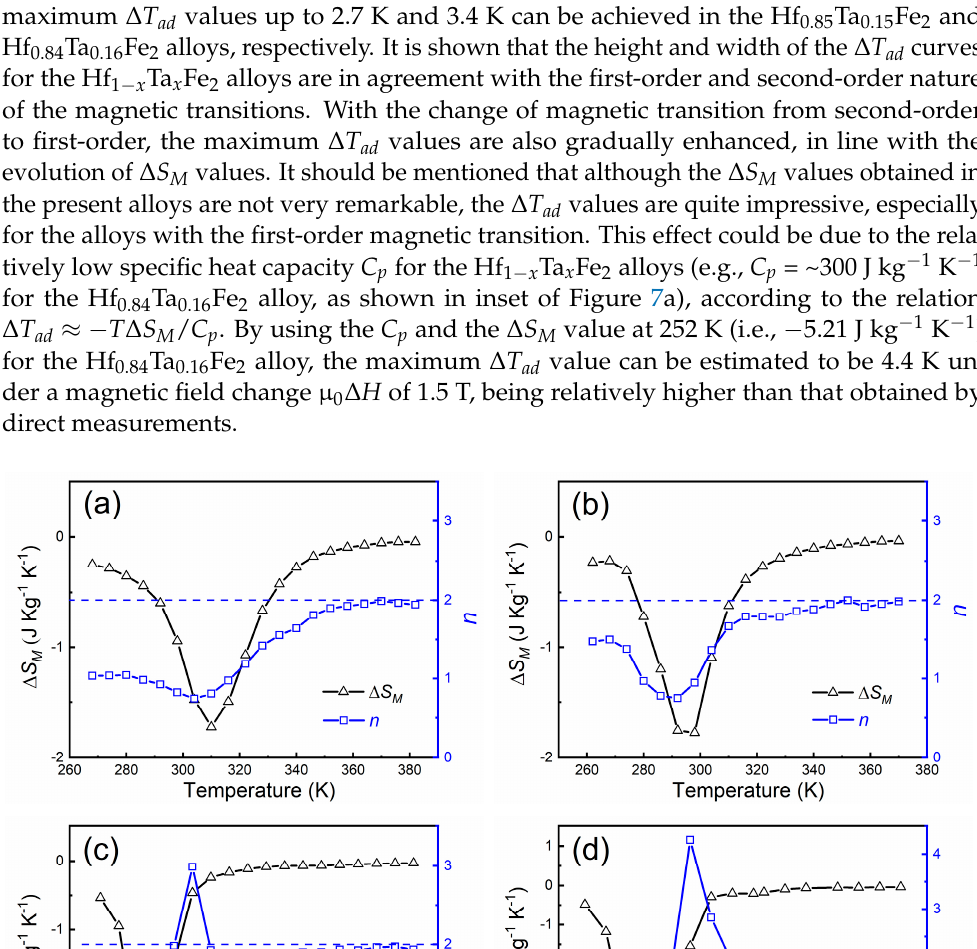
ence of Δ T ad values on cooling for the studied Hf 1- x Ta x Fe 2 alloys on applying the magnetic field of 1.5 T. For the Hf 0.87 Ta 0.13 Fe 2 and Hf 0.86 Ta 0.14 Fe 2 alloys with the second-order mag-